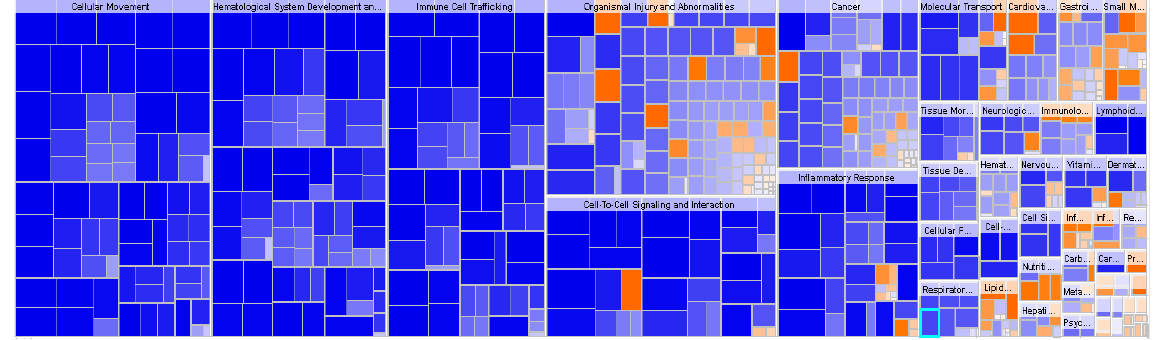
Figure 3. Functional category annotation analysis of obese individuals in IR-NGT group, when compared to lean group, shows inhibition of cellular movement, immune cell trafficking and cell-to-cell signaling and interaction. Blue color indicates inhibition; red color indicates activation.